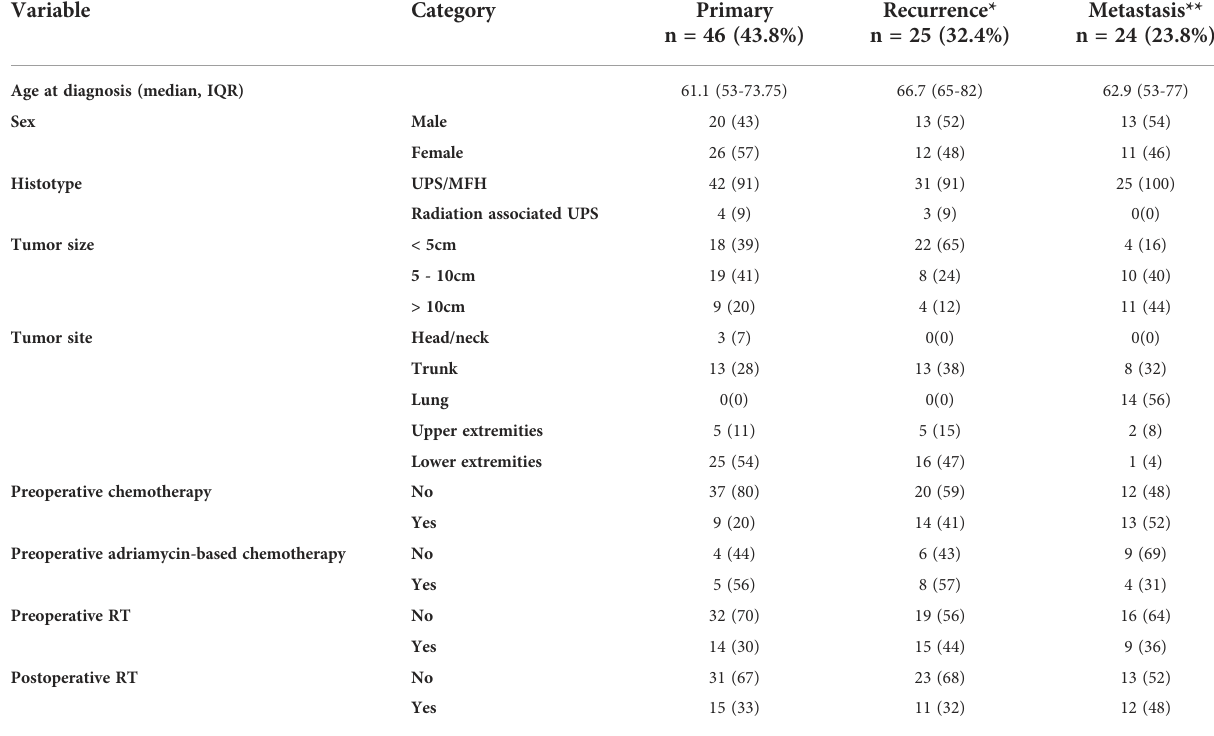
TABLE 1 Clinical characteristics of the cohort (primary, recurrence and